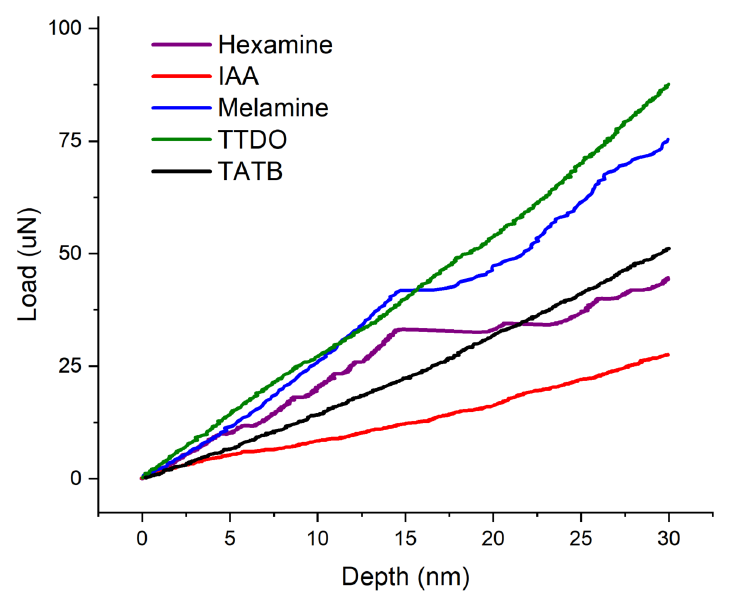
Figure 6. Typical yield behavior for hexamine, IAA, melamine, and TTDO. Load–depth data for TATB from data set in [17].